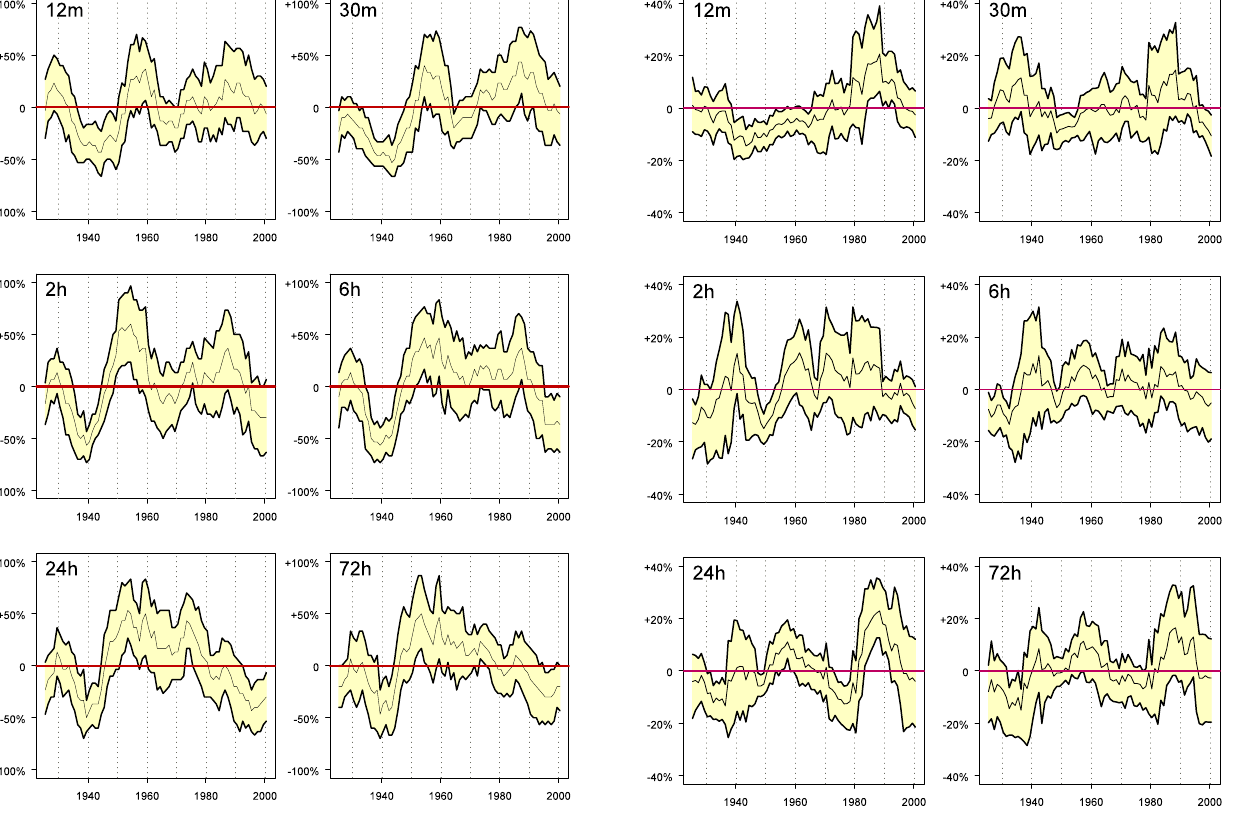
Fig. 3. As Fig. 2 but for